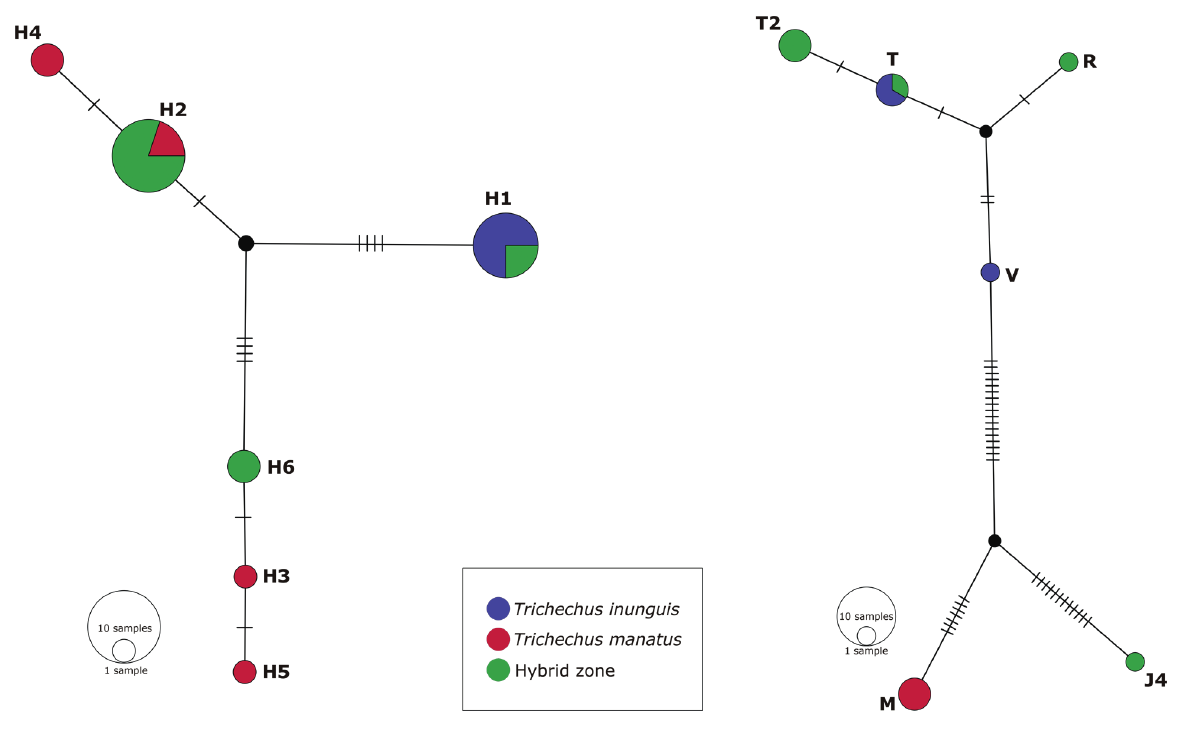
Figure 2 - Median-joining networks showing the parsimony relationships between haplotypes for RAg1 gene (left) and mtDNA control region (CR) (right). The diameter of the circles is proportional to the number of individuals with each haplotype. The transversal traces on the branches indicate the number of nucleotide substitutions. The colors refer to Trichechus inunguis (blue); Trichechus manatus (red); and manatee samples from the hybrid zone